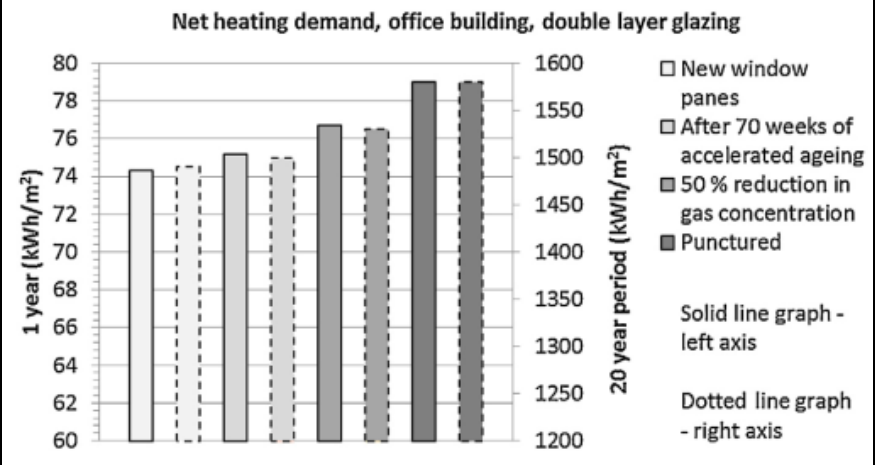
Figure 11. Net Heating Demand, Office Building, Double Layer Glazing [5].